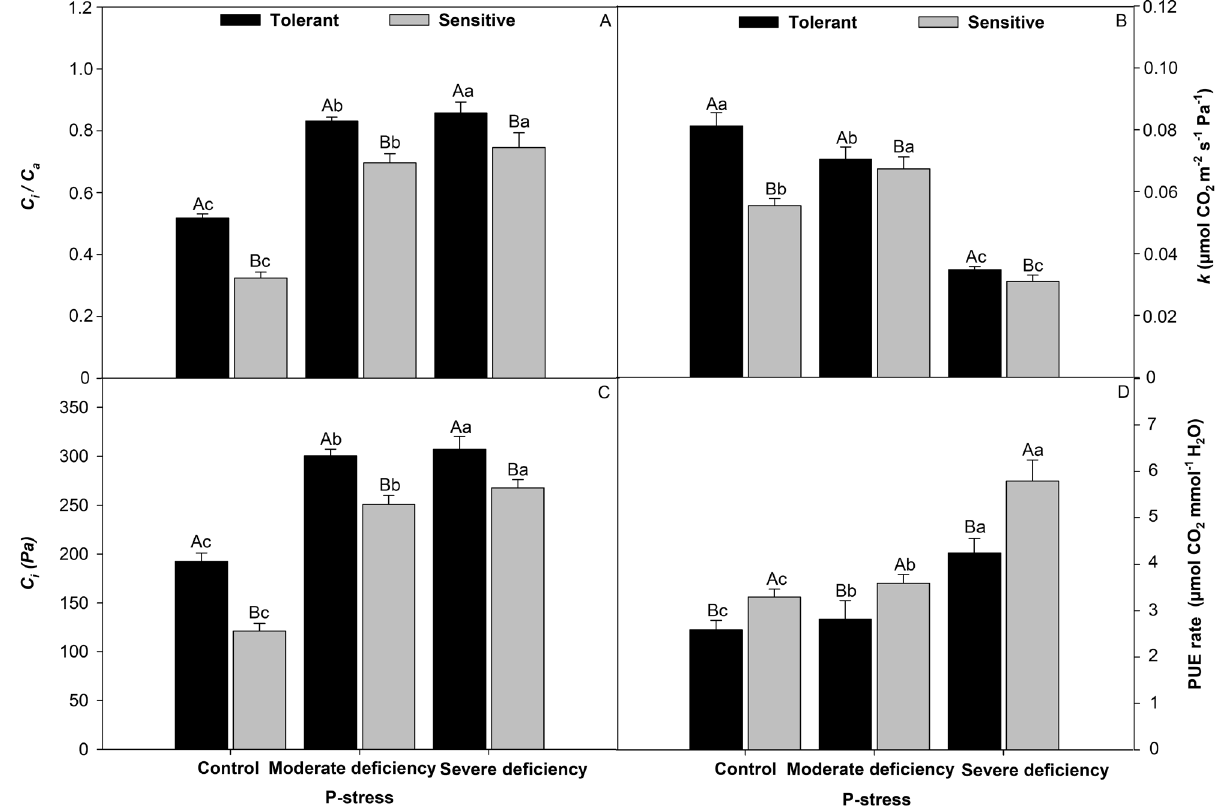
Figure 8. The internal carbon/atmospheric carbon ratio (Ci/Ca) refers to the relationship between the CO 2 concentration in the leaf mesophyll and the CO 2 concentration in the air outside the leaf, intercellular CO 2 concentration Ci (µmol CO 2 s −1 mol −1 ) ( A ), instant carboxylation efficiency ( B ), intercellular CO 2 concentration ( C ), P-use physiological efficiency ( D ) in tomato cultivars treated P-stress. Columns with different capital letters compare cultivars (tolerant and sensitive) between P stress levels (control, moderate deficiency, and severe deficiency). Lowercase letters compare cultivars (tolerant and sensitive) with the same color as a function of P stress levels (control, moderate deficiency, and severe deficiency). Different letters differ by the Scott–Knott test (P < 0.05). Columns corresponding to means of six repetitions and standard deviations.